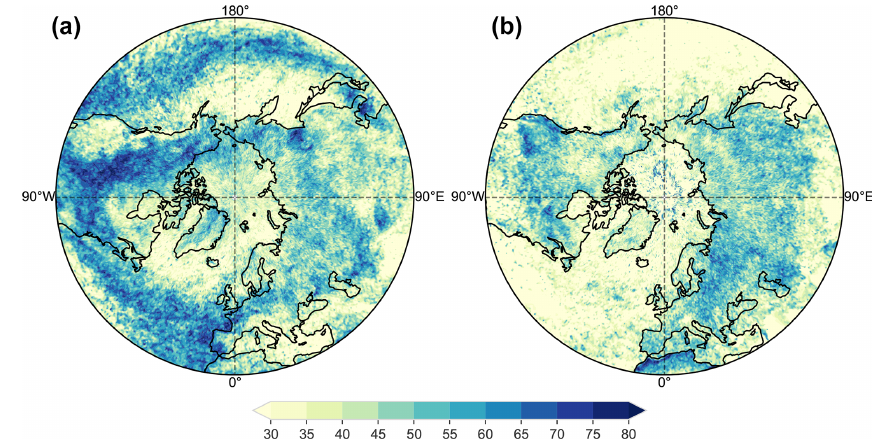
Figure 8. Relevance of weather systems (RWSs) for the P ( T ) relationship in DJF (a) and JJA (b)